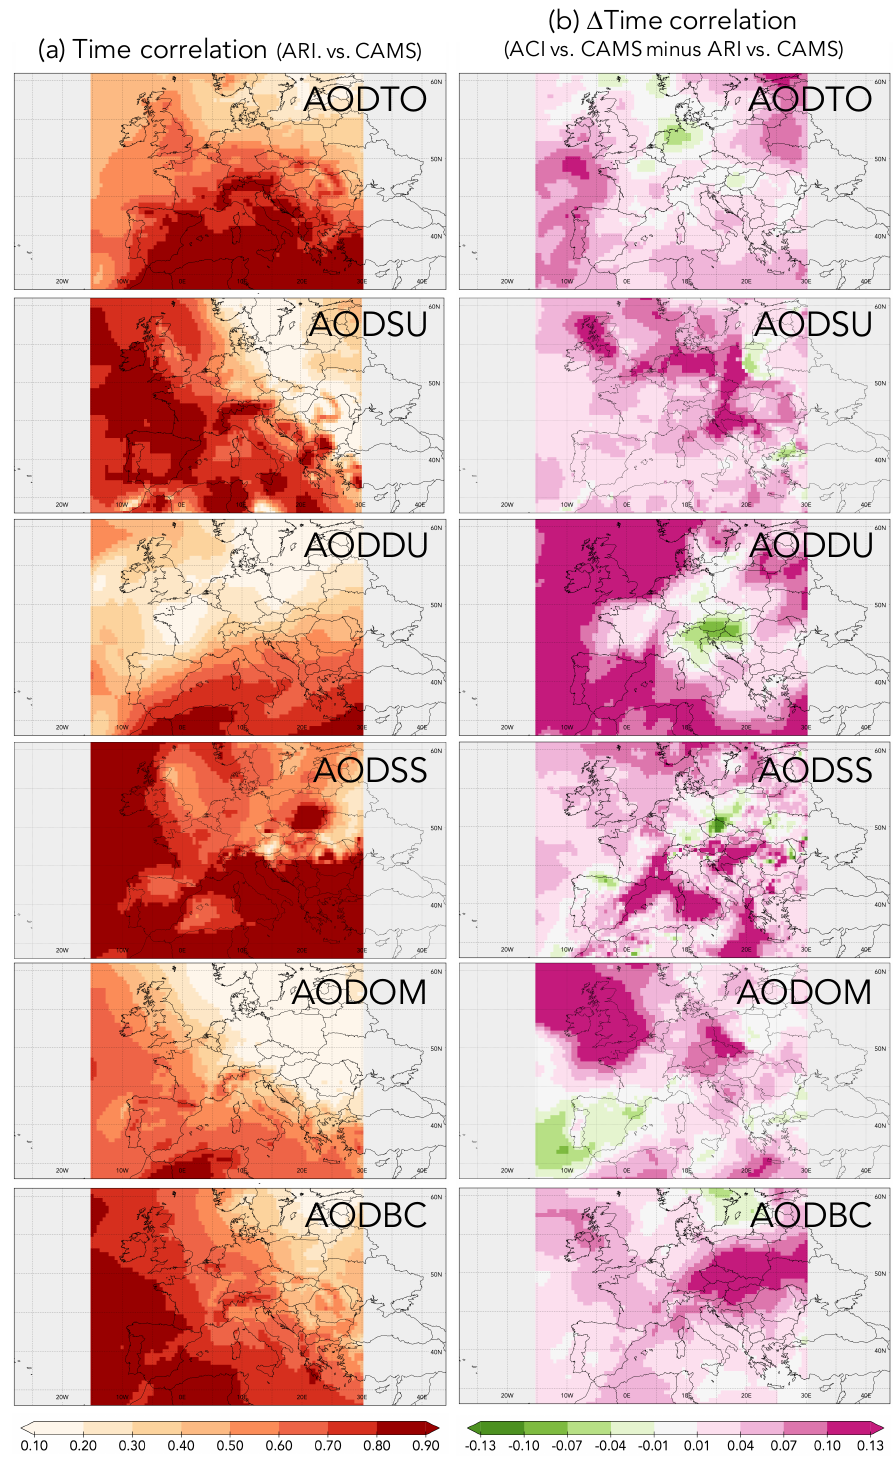
Figure 4. (From top to bottom: AODTO, AODSU, AODDU, AODSS, AODOM, AODBC). ( a ) Pearson correlation coefficient of base case simulations (ARI) with CAMS reanalysis for AOD at 550 nm. ( b ) Improvement in the correlation coefficient when including aerosol-cloud interactions with respect to the base case simulation. A positive(negative) number, represented by pink(green) colours, indicates a higher(lower) correlation coefficient in ACI simulations with respect to the base